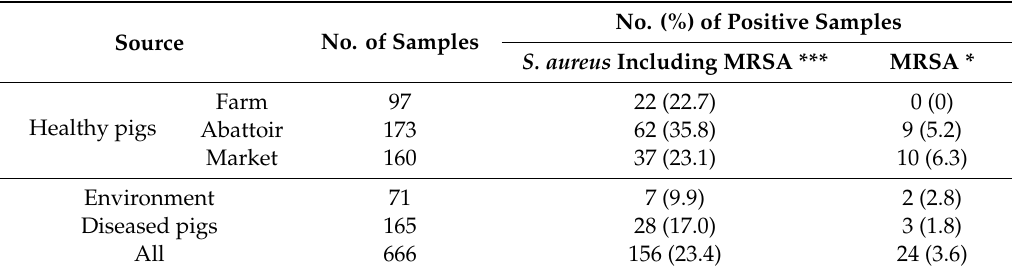
Table 1. Occurrence of S. aureus and MRSA in pork